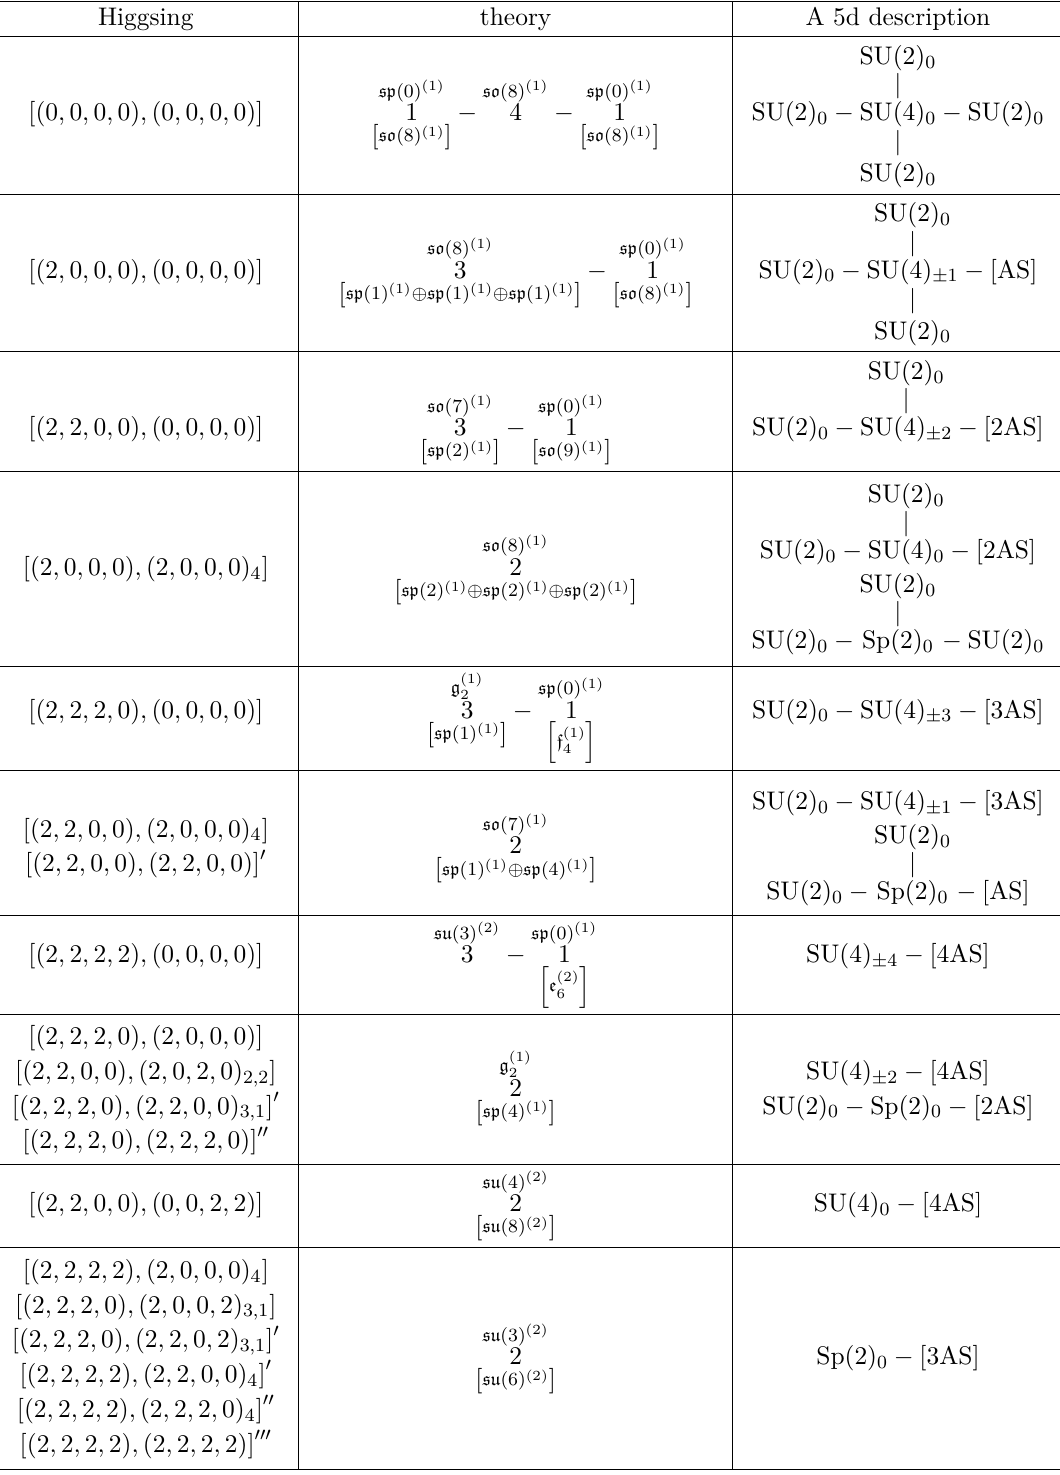
Table 2. Higgsings associated to SU(2) 4 × SU(2) 4 of (2.27). AS represents a hypermultiplet in the rank-2 antisymmetric representation of a gauge group which is connected to [ AS ]